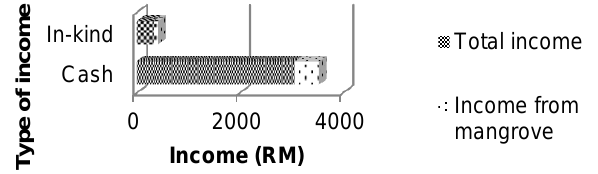
Figure 2: Average monthly household income in Kg Pasir Putih and Kg